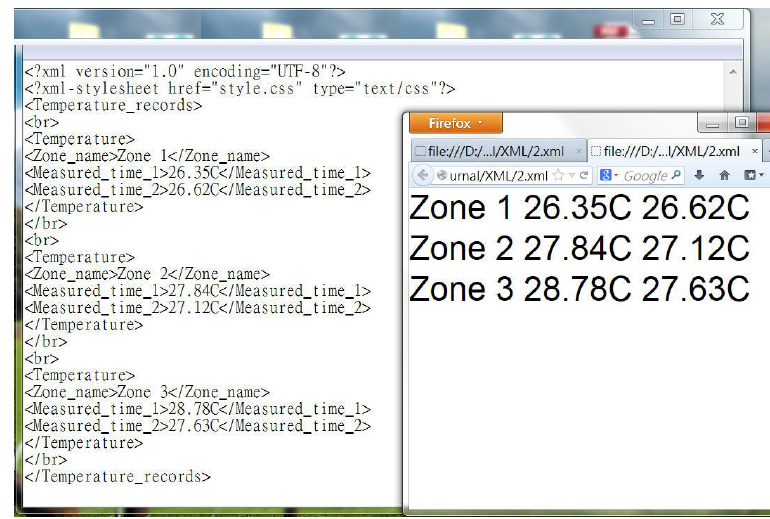
Figure 37. Data properties for easy